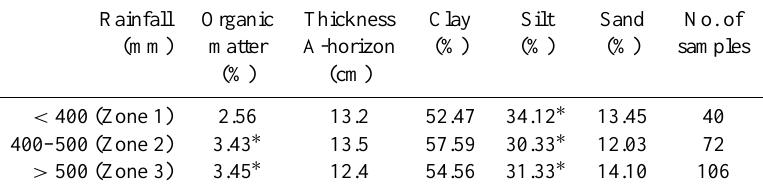
Table 5. Variation in soil properties according to rainfall zones. Rainfall Organic